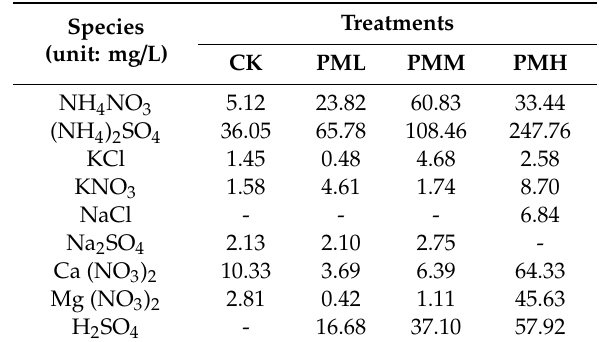
Table 1. Species of chemical substances and their quantities used in every 1 L of simulated WSII–PM 2.5 solution.